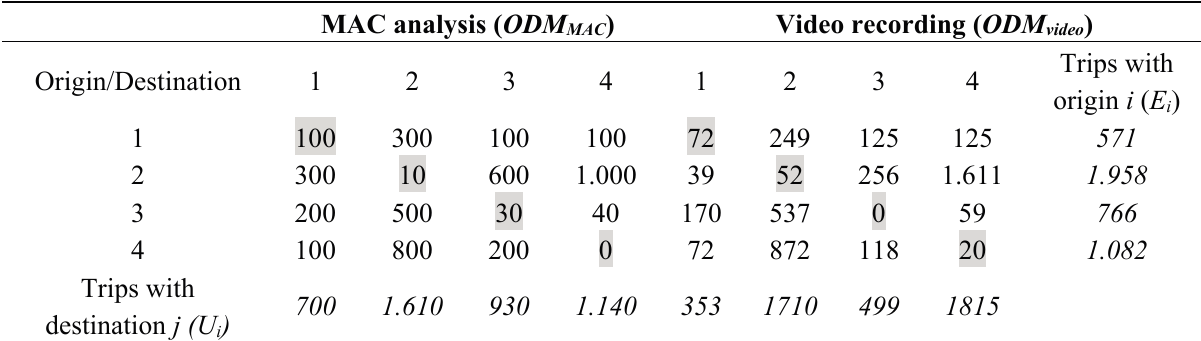
Table 5. O-D Matrix obtained through UIS compared with real observations. MAC analysis ( ODM MAC